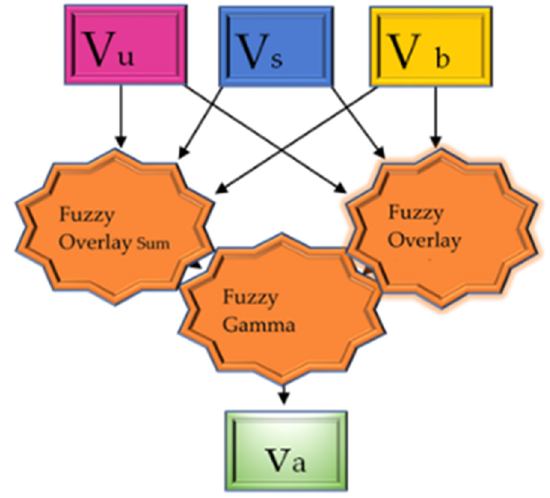
Figure 9. FOG was used to aggregate the three vulnerability indicators (urban, social and building) into a single indicator, called the aggregated vulnerability Indicator.